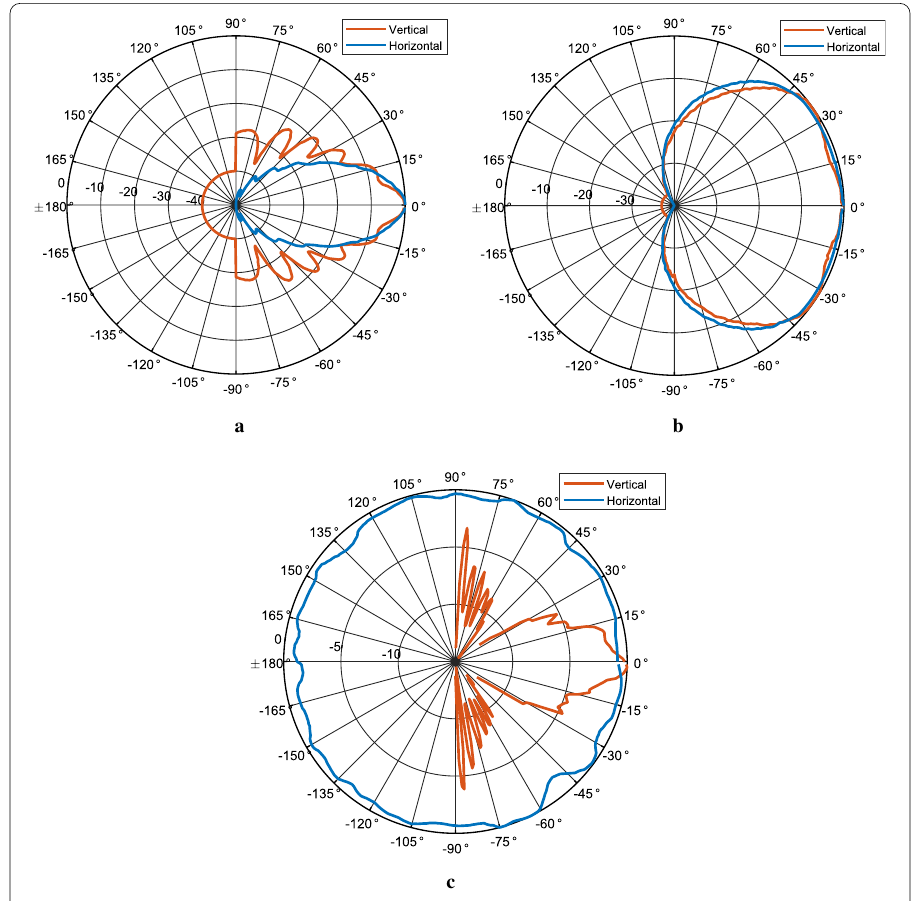
Fig. 2 Antenna radiation patterns, a Antenna with 10 ◦ and 13 ◦ HPBW in V and H-plane, respectively, b antenna with 100 ◦ HPBW in both V and H-plane, and c omnidirectional antenna with 30 ◦ and 360 ◦ HPBW in V and H-plane,